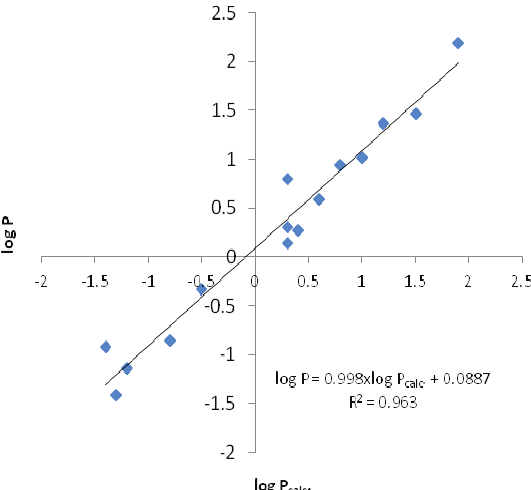
Figure 8. Plot of Log P vs. log Pcalc. by similarity